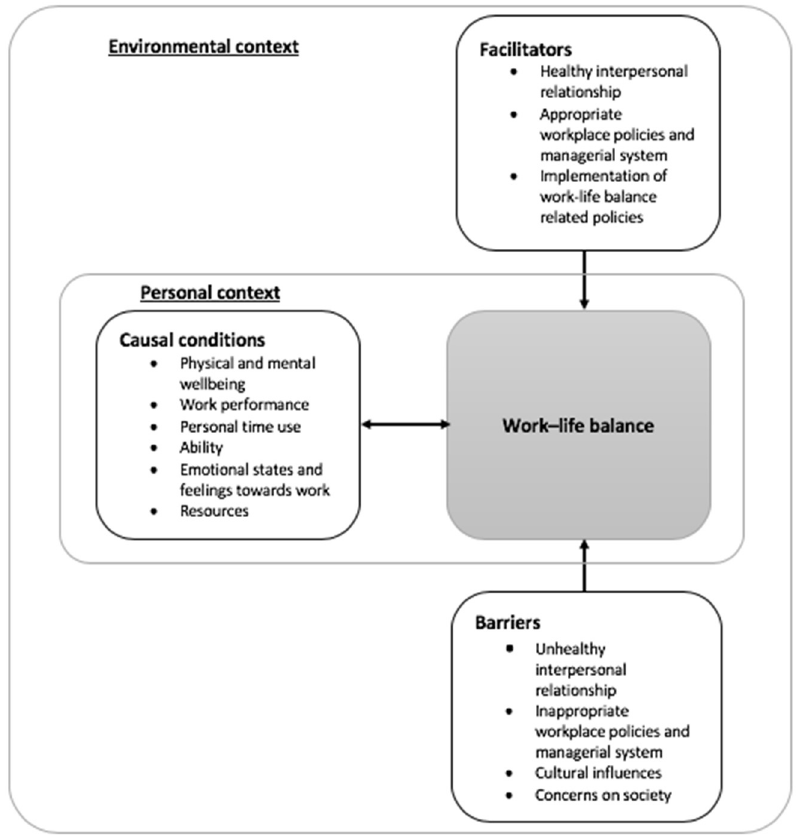
Figure 1. Grounded theory model for work–life balance.